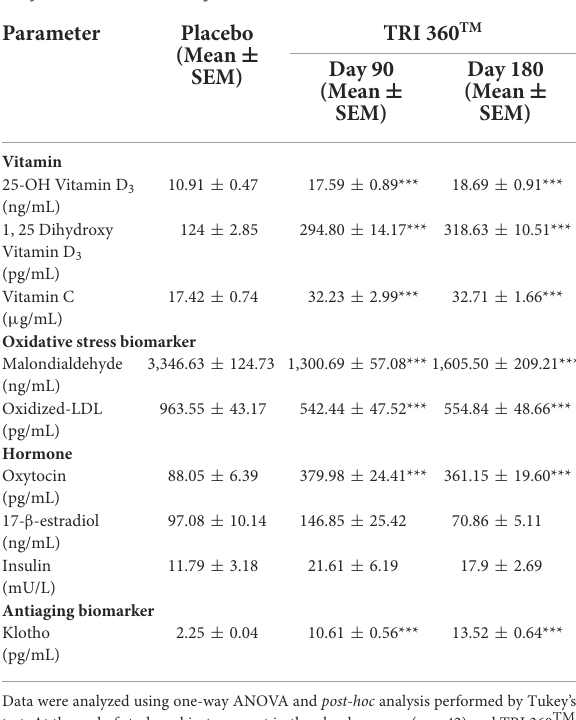
TABLE 3 Measurement of serum biomarkers related to vitamins, oxidative stress, hormones, and aging in serum after treatment with the proprietary dietary supplement (TRI 360 TM ) capsules in human subjects, measured at days 90 and